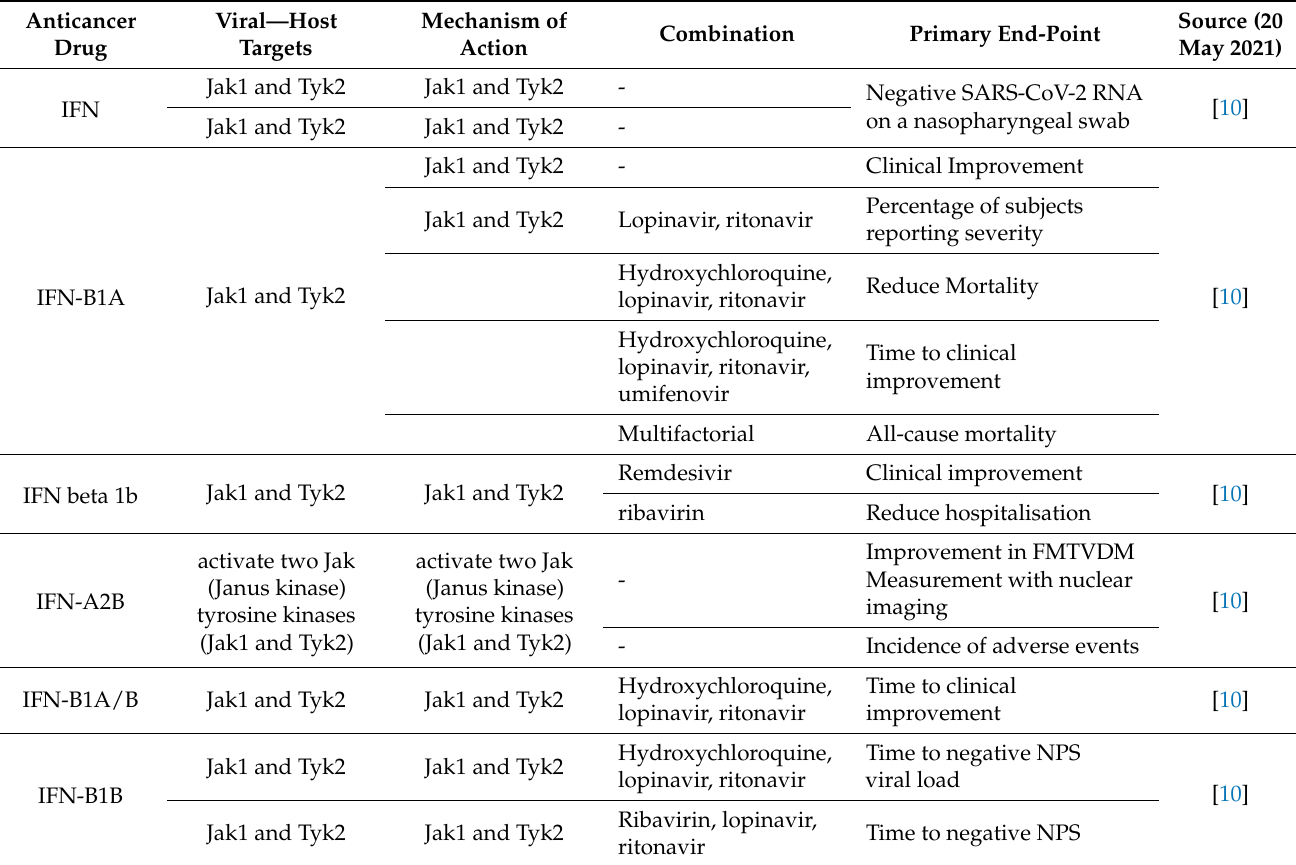
Table 1. Anticancer drugs in clinical trials for COVID-19: Interferon-based therapies. Anticancer